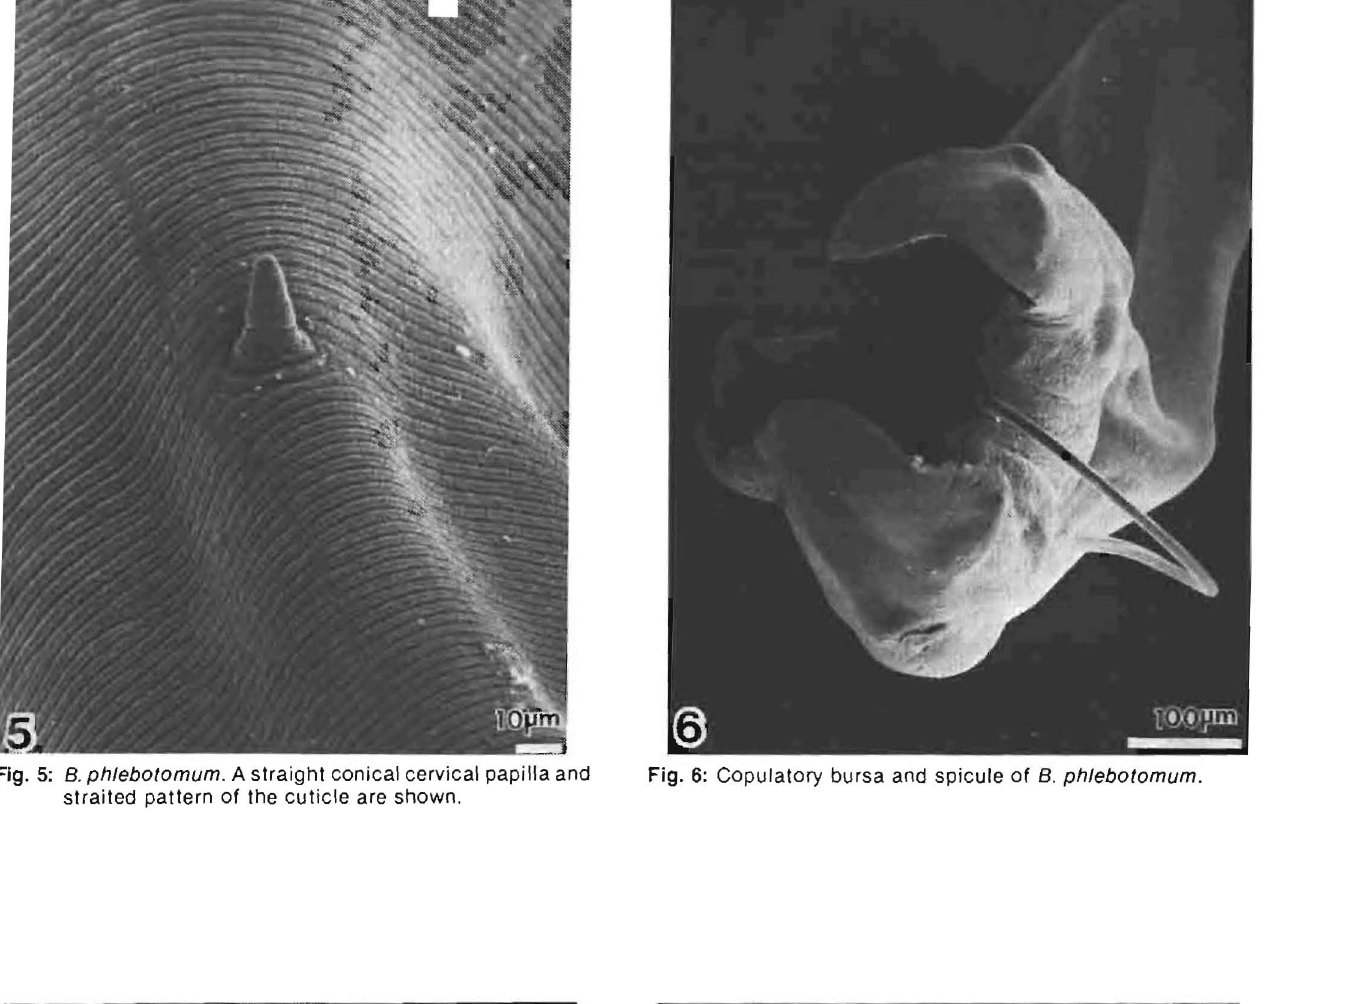
Fig. 6: Copulatory bursa and spicule of B. phlebotomum.